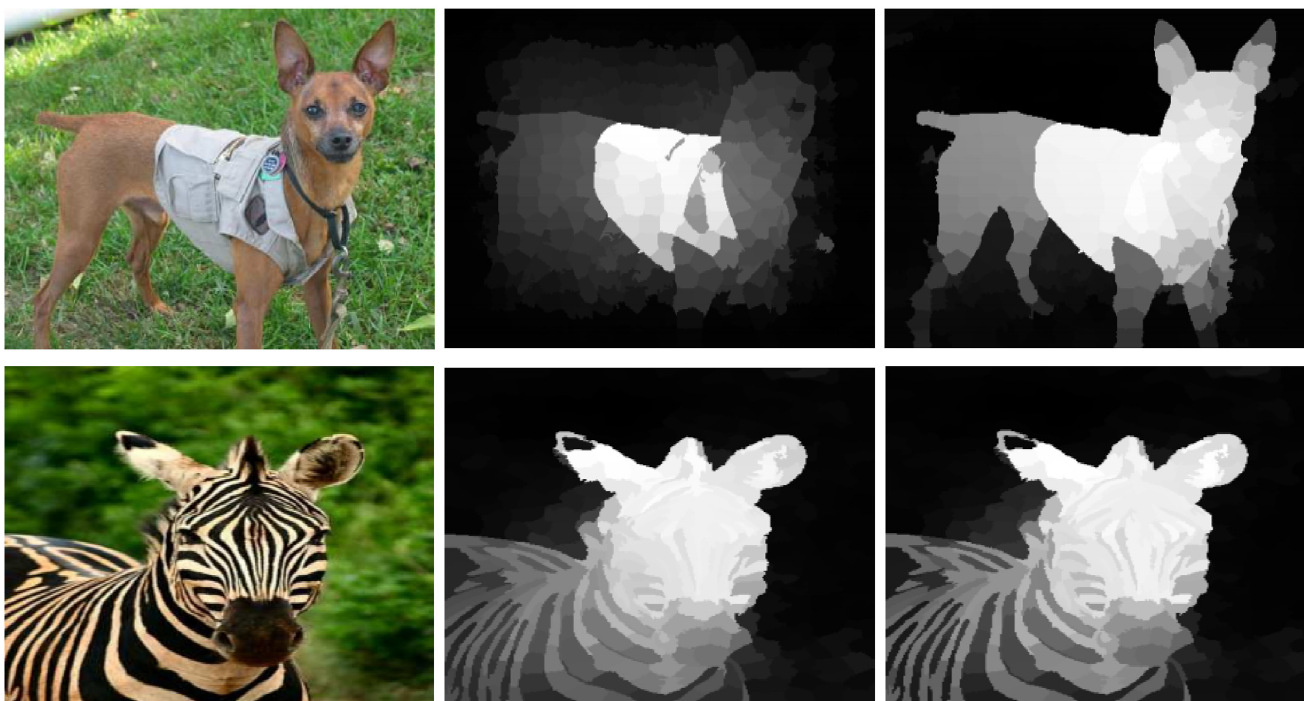
Fig 3. Importance of the visual as well as the textural features for computing a good saliency map is clear from the demonstrated results. The results demonstrated in the first row reveal that the results generated using one color model miss a lot of image information. However, the second row demonstrates that the saliency without the textural features is not significant. Therefore, both the visual and the textural features are equally important for computing the accurate saliency results. The results are similar but not identical to the original images and is therefore for illustrative purposes only.